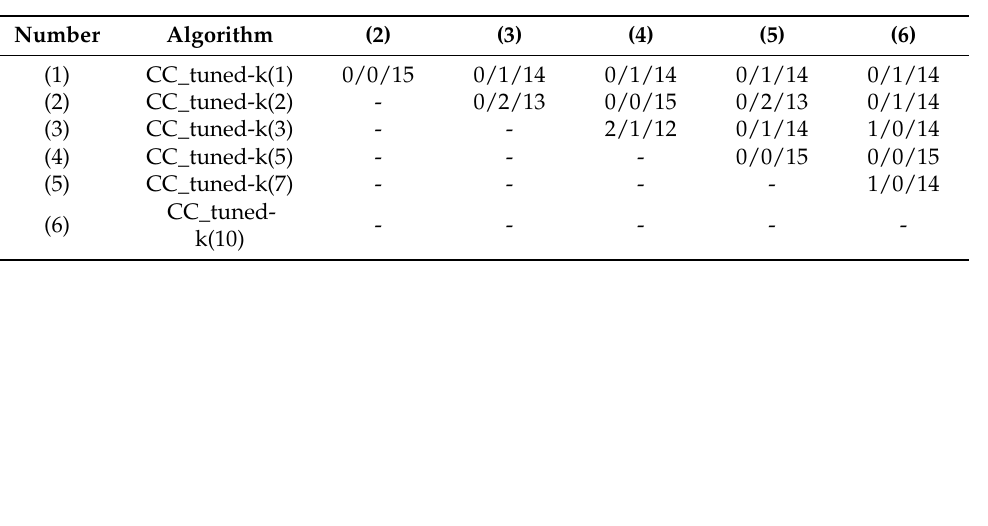
Table 6. The results of the Wilcoxon test for CC-k with different parameter